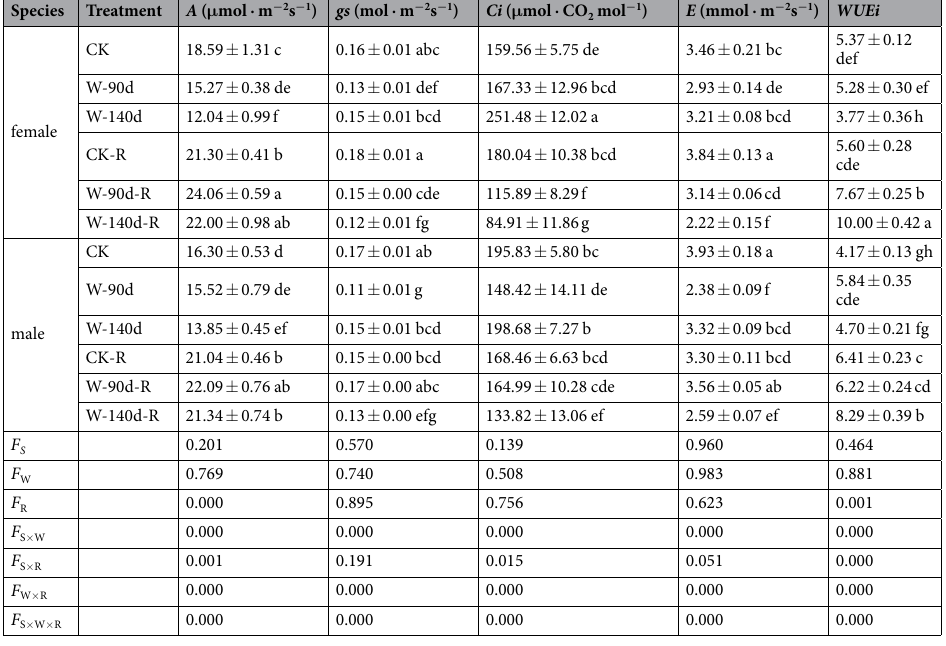
Table 1. Net photosynthetic rate ( A ), transpiration ( E ), stomatal conductance ( gs ), intercellular CO 2 concentration ( Ci ) and intrinsic water use efficiency ( WUEi ) variations in male and female P. deltoids under winter flooding stress and post-flooding recovery. CK, control treatment; W, flooding and waterlogging stress treatment; R, recovery after waterlogging stress. Values are means ± SE ( n = 5). Letters above the columns indicate significantly differences at P < 0.05 according to Duncan’s test. The significance values of the factorial analysis (ANOVA) for: F S , F W , and F R refer different effects of species, watering, and recovery growth, respectively;